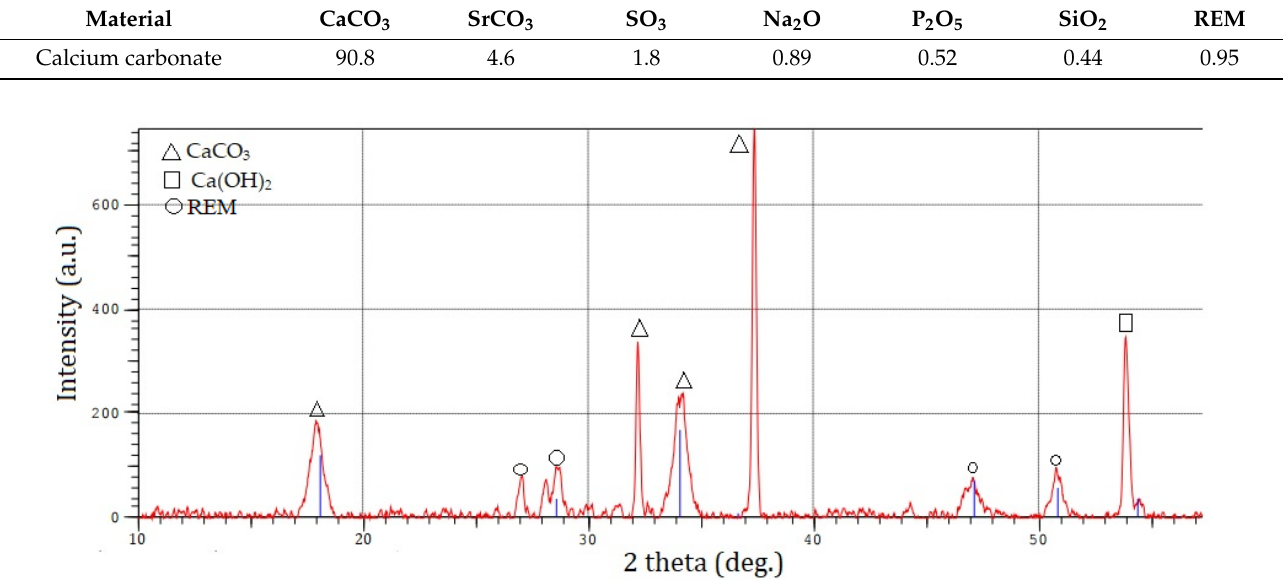
Table 6. Chemical composition (wt. %) of calcium carbonate laboratory samples.